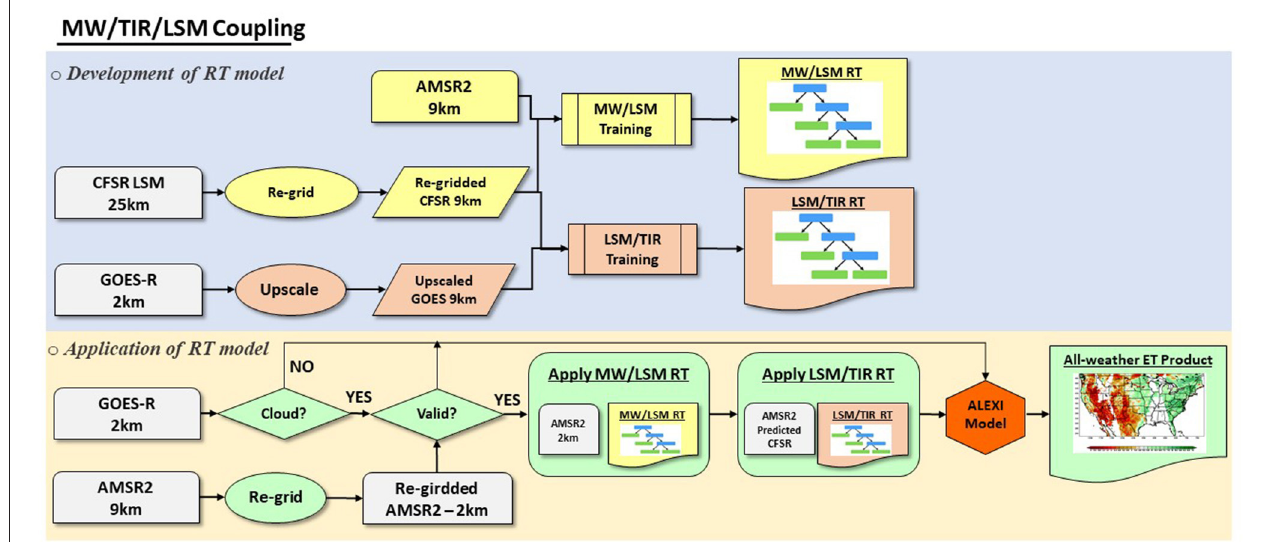
FIGURE 3 | Data flow of the development of the regression tree model for merging microwave (MW), thermal infrared (TIR) and land surface temperature (LSM)